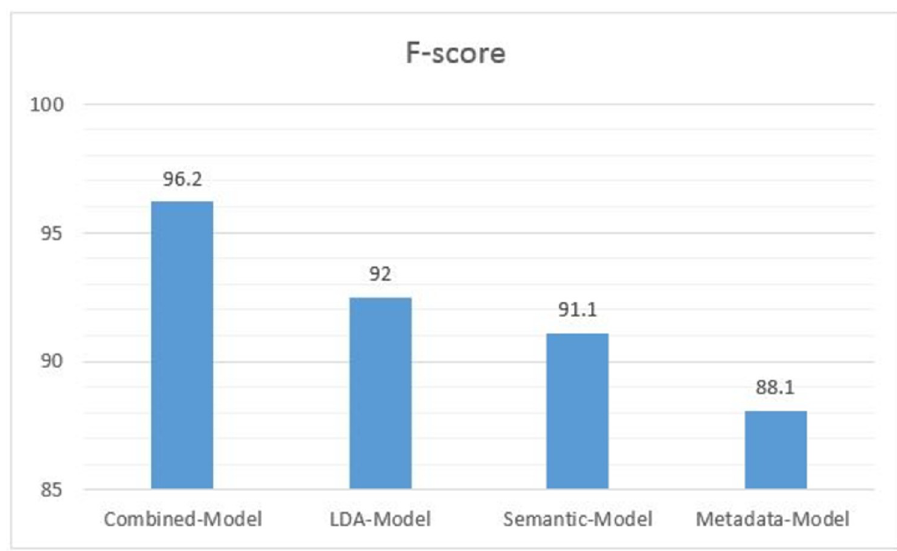
Fig 3. Comparison of models’